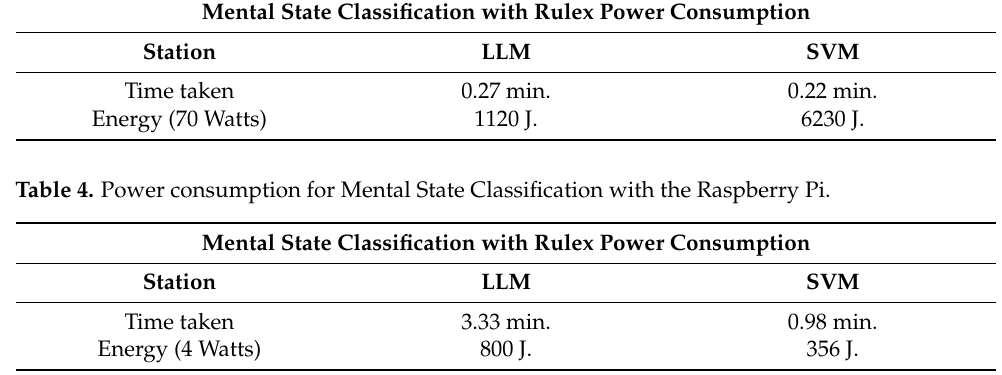
Table 3. Power consumption for Mental State Classification for HP laptop.